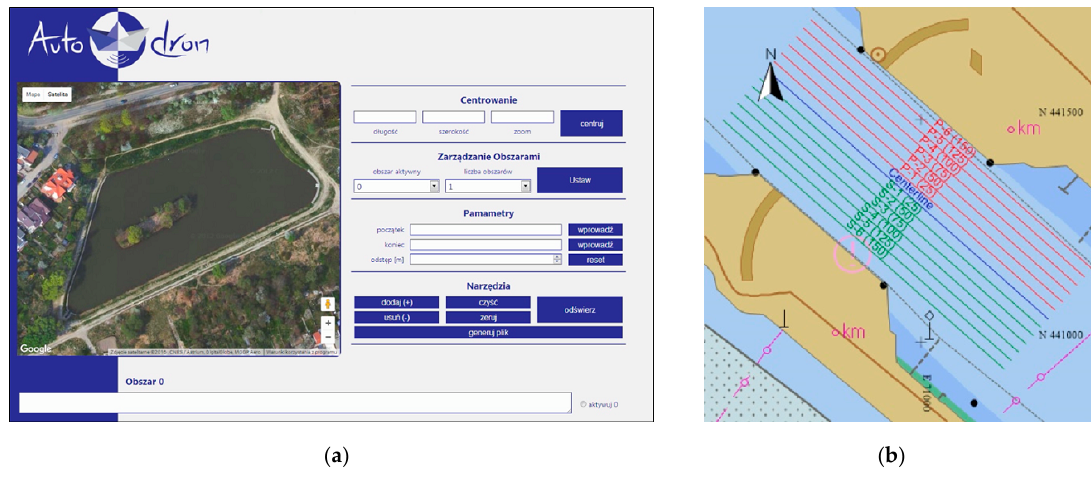
Figure 2. Applications used to plan sounding work, such as AutoDron ( a ) [26] and QINSy ( b ).